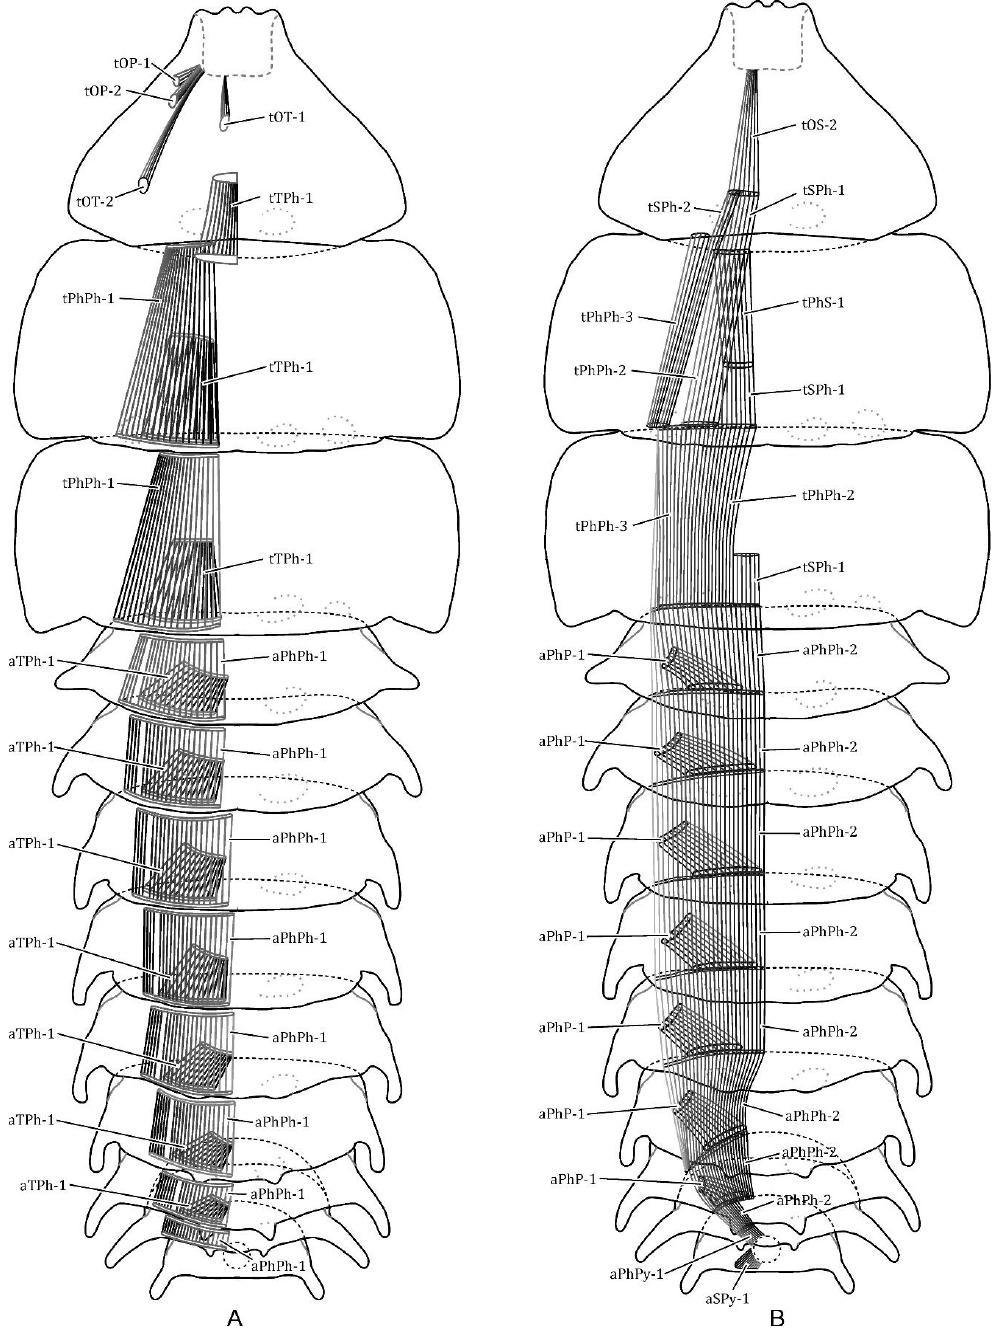
Figure 9. Platerodrilus svetae , female. ( A ) — dorsal longitudinal muscles; ( B ) — ventral longitudinal muscles. Explanations in text.